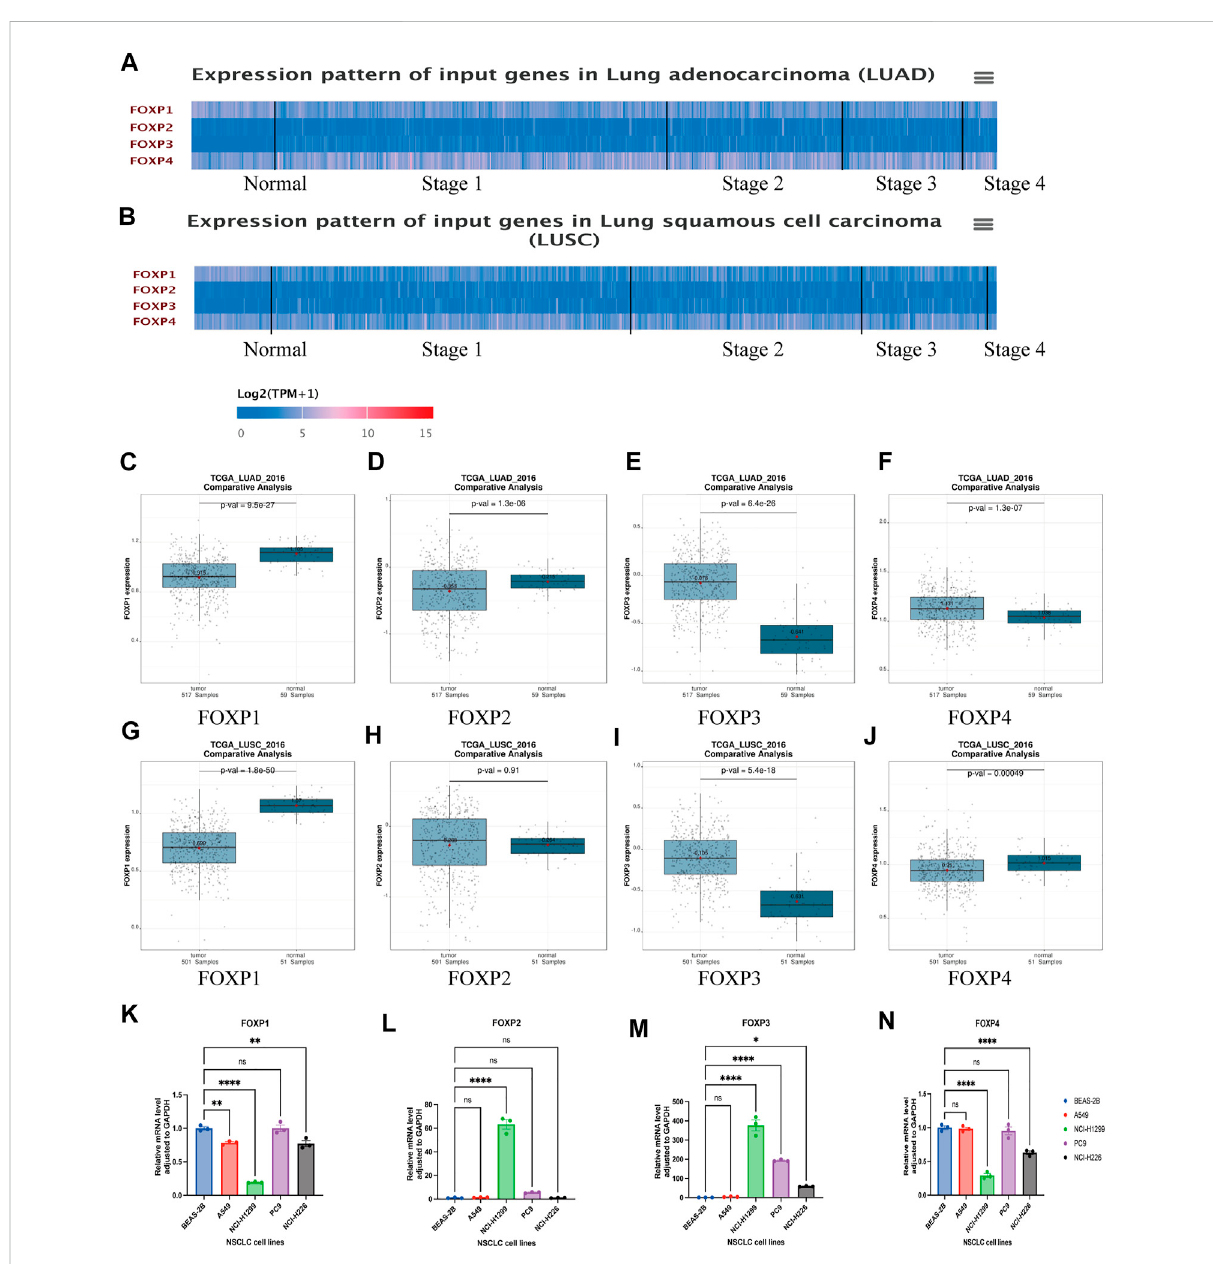
FIGURE 2 The differential expression of FOXP family in NSCLC. (A) The heatmap represented the transcriptional levels of FOXP family in patients with LUAD compared with normal samples using UALCAN. (B) The heatmap represented the transcriptional levels of FOXP family in patients with LUSC compared with normal samples using UALCAN. (C – J) The compare the mRNA expression of FOXP1/2/3/4 between LUAD/LUSC and normal tissue samples by using GEPIA dataset; The box plot showed the relative expression levels of family in normal tissue and NSCLC tissue. p < 0.05 was de fi ned as statistically signi fi cant. (K – N) The mRNA levels of FOXP family between LUAD cell lines (A549, NCI-H1299, and PC9)/LUSC cell line (NCI- H226) and normal human lung epithelial cell line (BEAS-2B) by RT-qPCR. (Legend: *** p ≤ 0.001; ** p ≤ 0.01; * p ≤ 0.05; ns. p > 0.05; LUAD, Lung adenocarcinoma; LUSC, Squamous cell carcinoma of lung; FOXP, Forkhead box P; RT-qPCR, Reverse transcription-quantitative polymerase chain